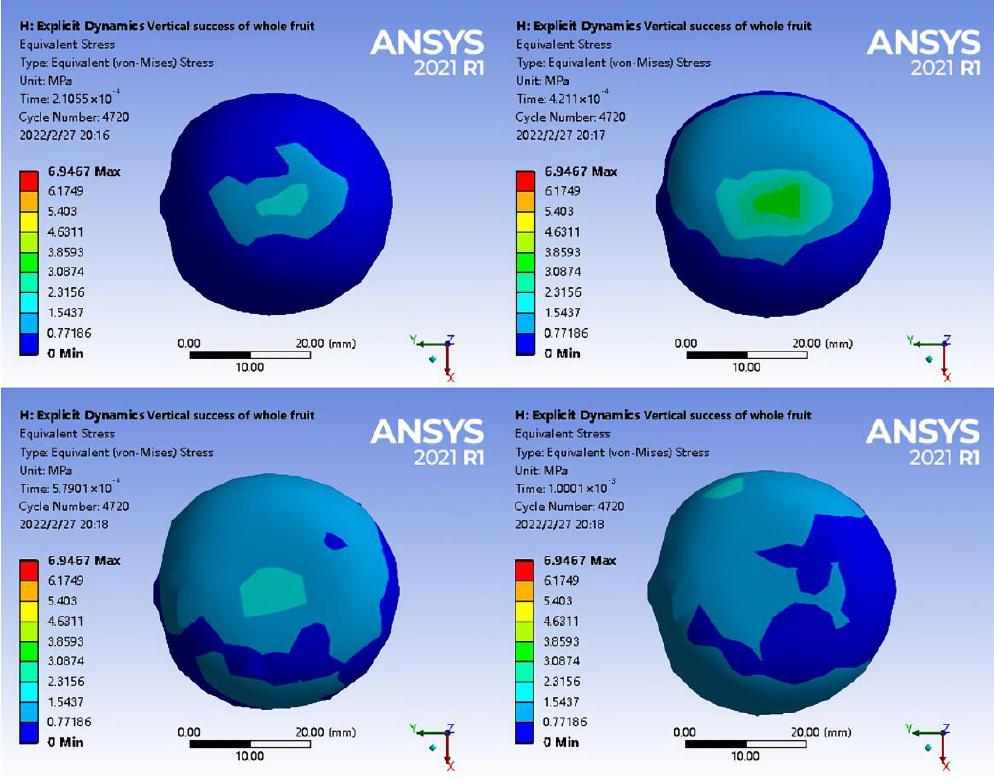
Figure 13. Radial loading stress change diagram of intact fruit.